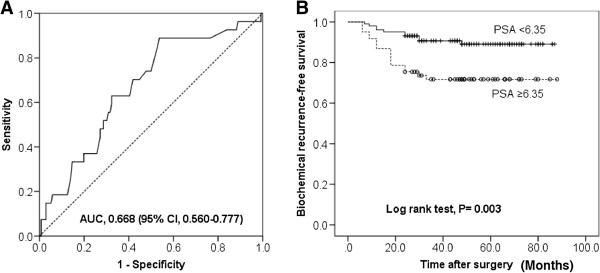
Pre-operative serum PSA levels correlated with the increased rate of the biochemical recurrence. (A) Optimal cut-off value of PSA for predicting the biochemical recurrence. (B) Biochemical recurrence-free survival according to PSA level.